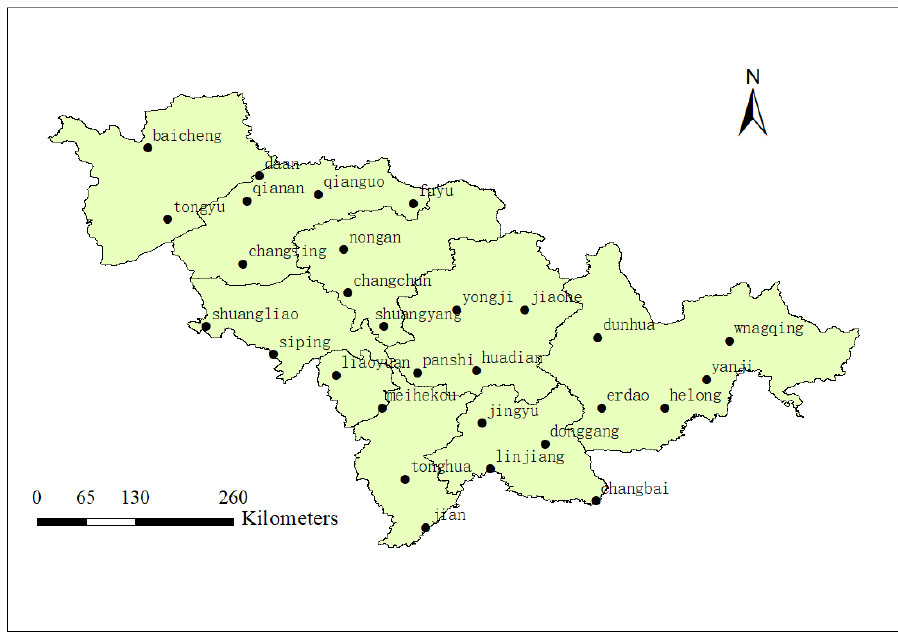
Figure 1. Distribution map of 29 selected surface meteorological observation stations.